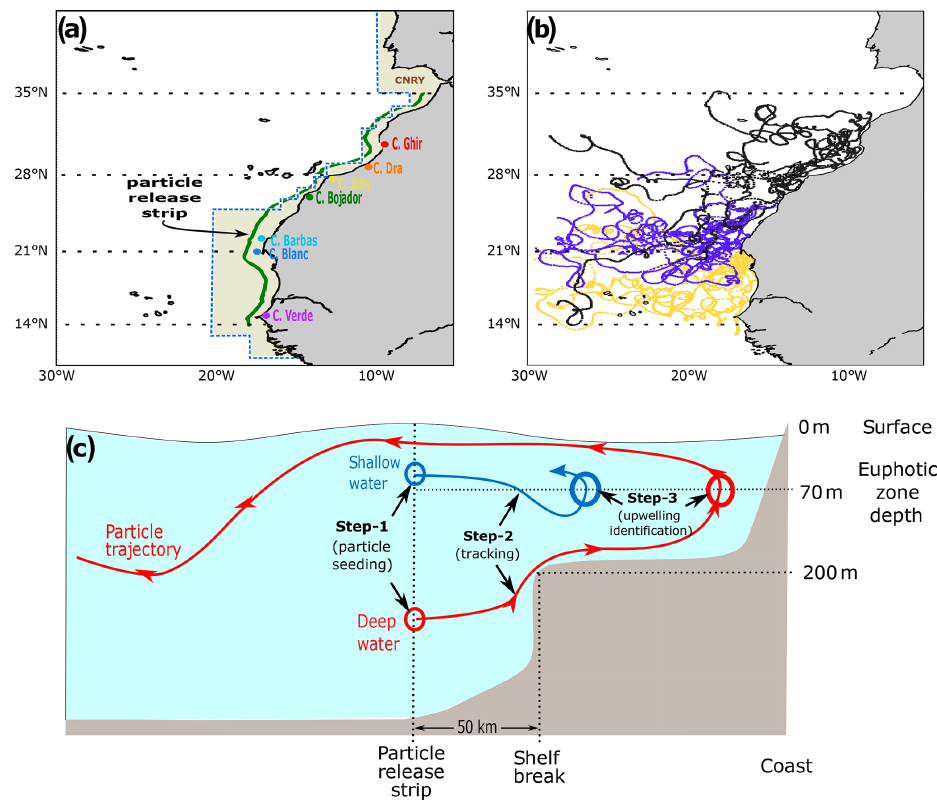
Figure 1. (a) The model domain stretches from 30 to 6 ◦ W and from 10 to 41 ◦ N. The solid green line indicates the limit of the coastal strip where particles are released at each vertical layer proportionally with the onshore water volume transport. The black dotted lines partition the domain into the three latitudinal subregions: the southern CanCS (14–21 ◦ N), the central CanCS (21–28 ◦ N) and the northern CanCS (28–35 ◦ N). The yellow-shaded area corresponds to the portion of the Longhurst Canary Coastal Province (CNRY) that lies within the model domain. The location of the seven capes studied in Sect. 5.1 is shown here in different colors. (b) A plot of sample trajectories of 10 randomly selected particles in our Lagrangian experiment from each of the southern (golden), central (blue) and northern (black) subregions. (c) A schematic of the Lagrangian sampling of upwelling particles. In step 1, particles are released when open-ocean water enters the coastal strip. Based on their depth when released, we term particles to be of a shallow ( < 70m) or deep ( > 70m) source. In step 2, the trajectories of the particles are tracked for up to 2 years. In step 3, upwelling particles are identified as those that cross the 70m depth while at the